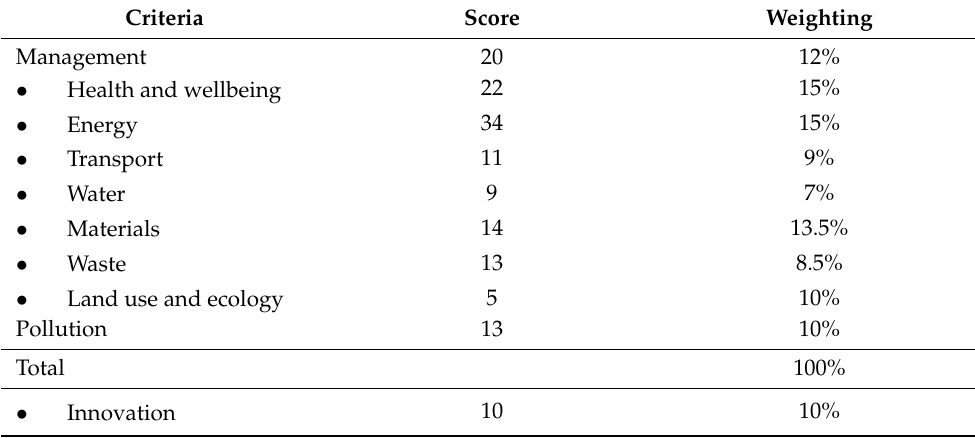
Table 3. Criteria of BREEAM INDR 2015.